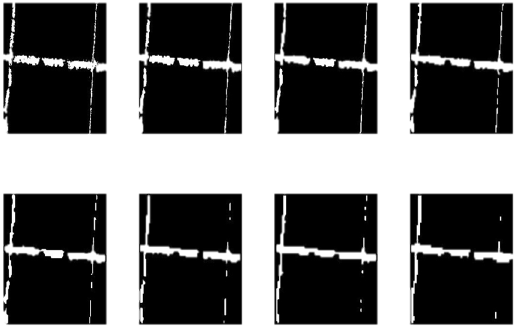
Figure 5. result of multi-resolution morphological algorithm on binary image